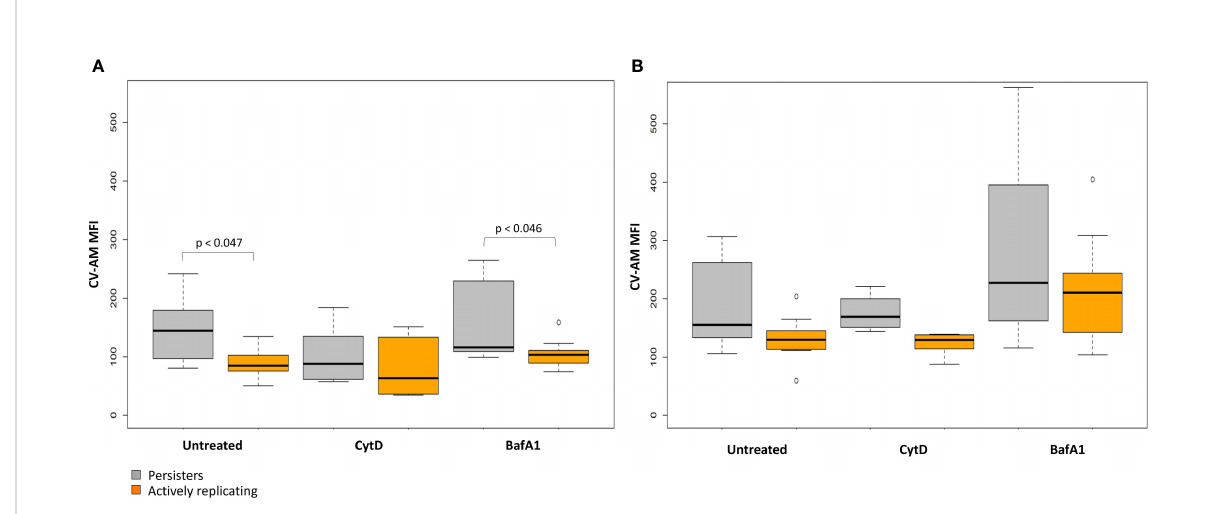
FIGURE 9 Metabolic esterase activity of persisters is in fl uenced by macrophage antimicrobial processes. The MFI of CV-AM from the actively replicating and persister subpopulations was assessed at day 3 and day 5. No signi fi cant differences between groups was observed at (A) day 3 (p = 0.198), (B) whilst signi fi cant differences between groups was observed at day 5 (p = 7.35e -8 ; repeated measures ANOVA). Signi fi cance testing between groups is listed in Table 5 and 6. Box and whisker plots express distribution of data independently conducted in 4 biological experiments, including technical triplicates, indicating the median (bold line), interquartile range (box), and range (whiskers). MFI, median fl uorescent intensity.